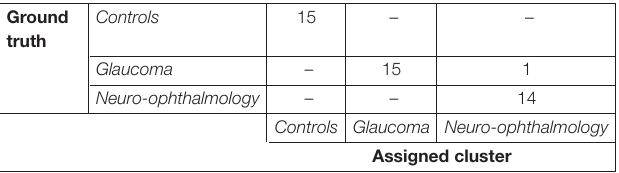
TABLE 3 | Confusion matrix for the clustering analysis on the gaze data from the VR device. Controls 15 Ground truth